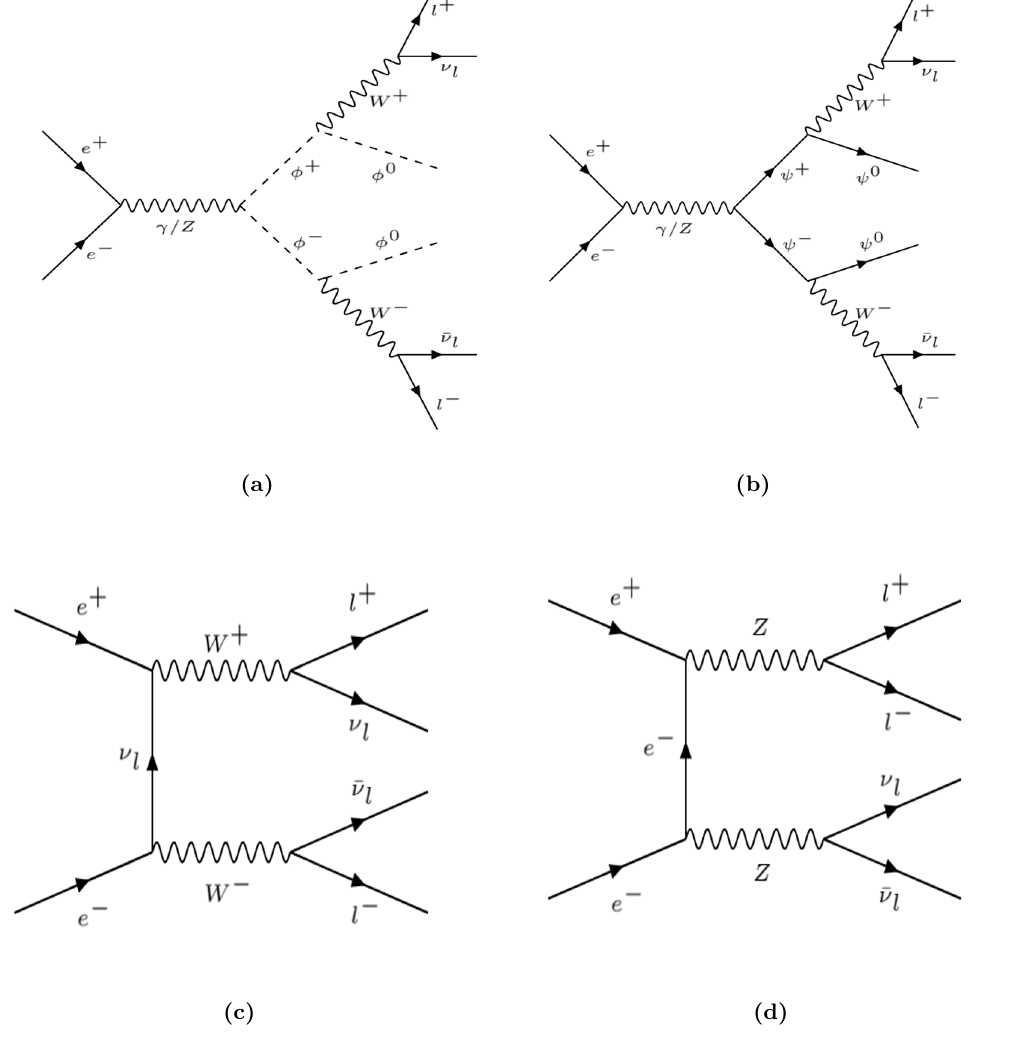
Figure 10. Dominant process contributing to ‘ + ‘ − + /E at ILC from the two component dark sector signal (top) and WW and ZZ background